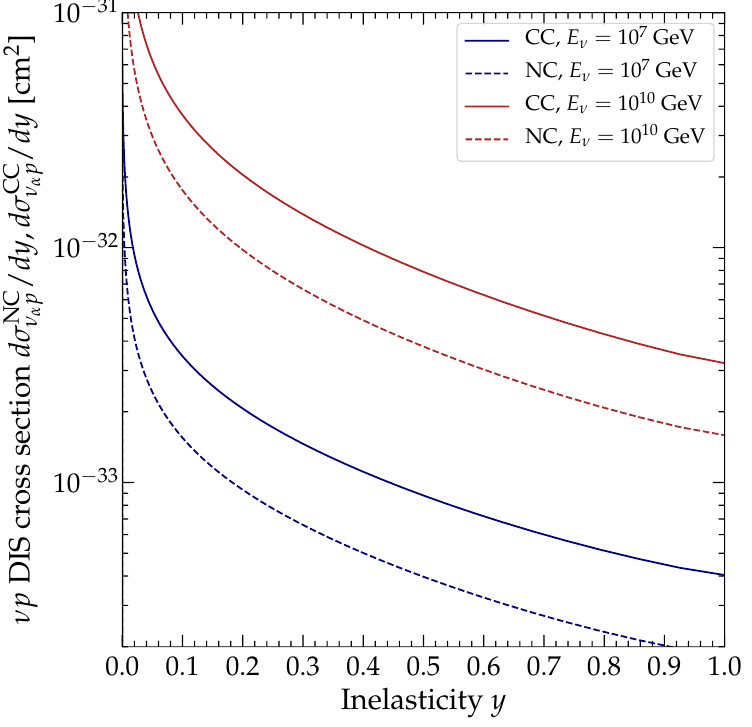
Figure 4 . Inelasticity distributions in neutrino-proton ( νp ) DIS for the BGR18 cross section [63], for two illustrative neutrino energies. We use the inelasticity distributions to compute the expected shower rate at IceCube-Gen2 in section 6.4. At the energies relevant to our analysis, the distributions are equal for ν and ¯ ν of all α α